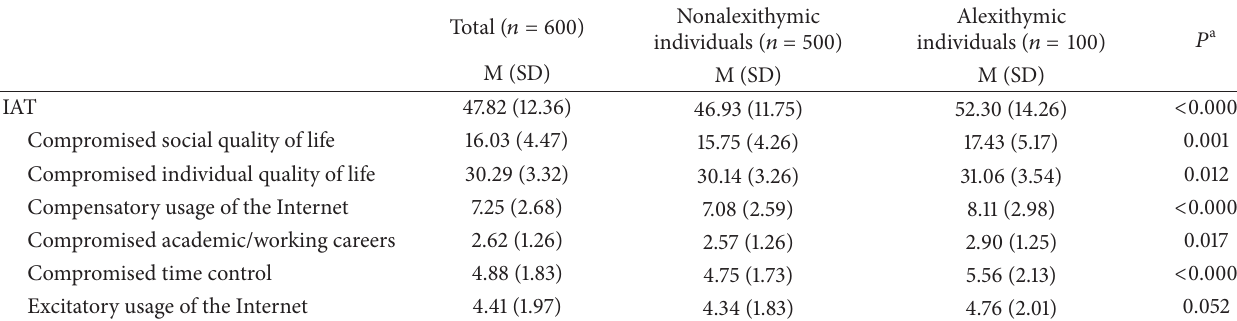
Table 3: Descriptive statistics of internet addiction test scores by alexithymia.